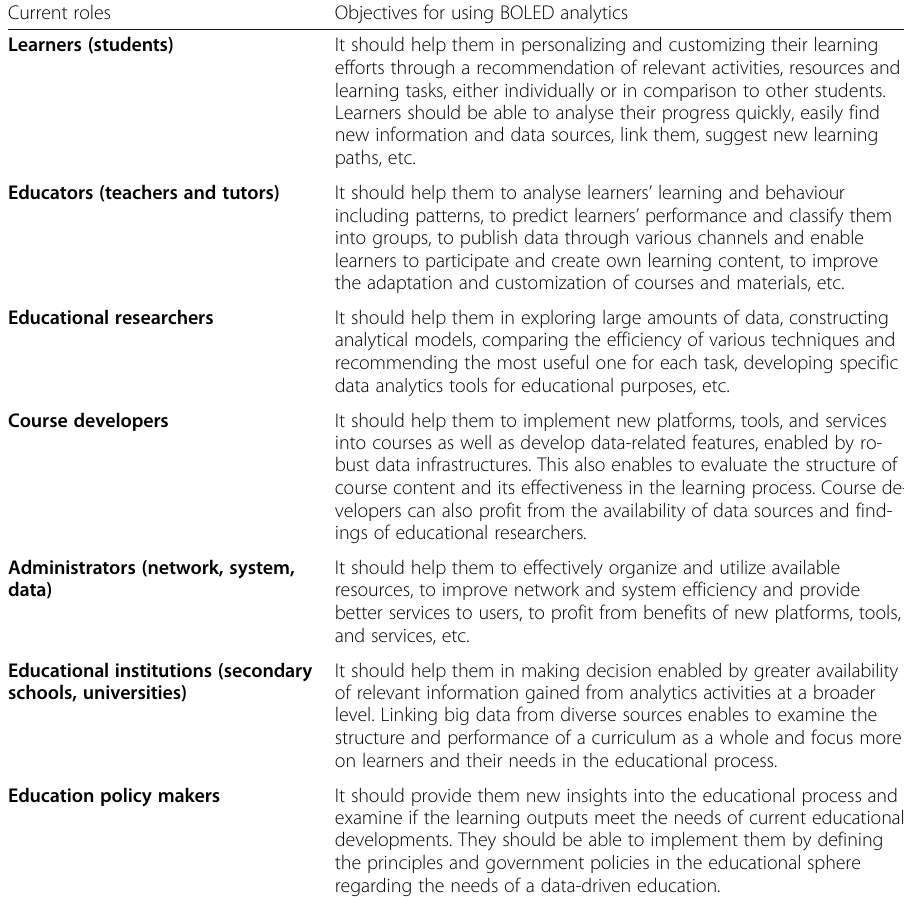
Table 3 A list of current roles of stakeholders in the educational process Current roles Objectives for using BOLED